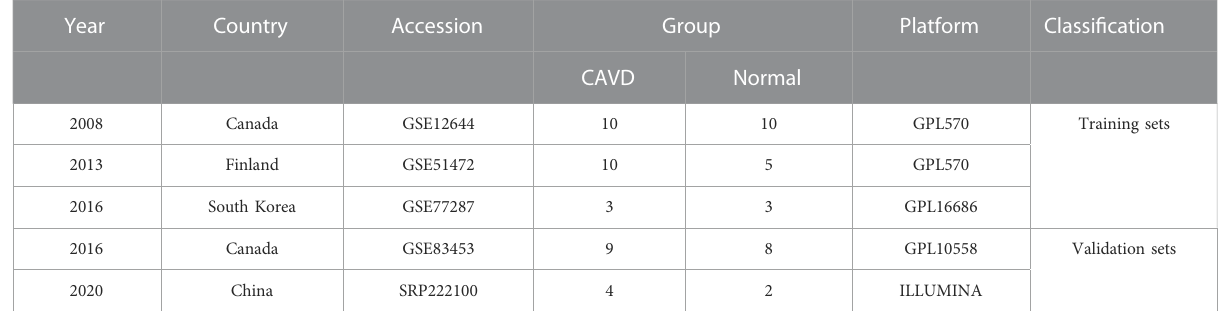
TABLE 1 Datasets used in this